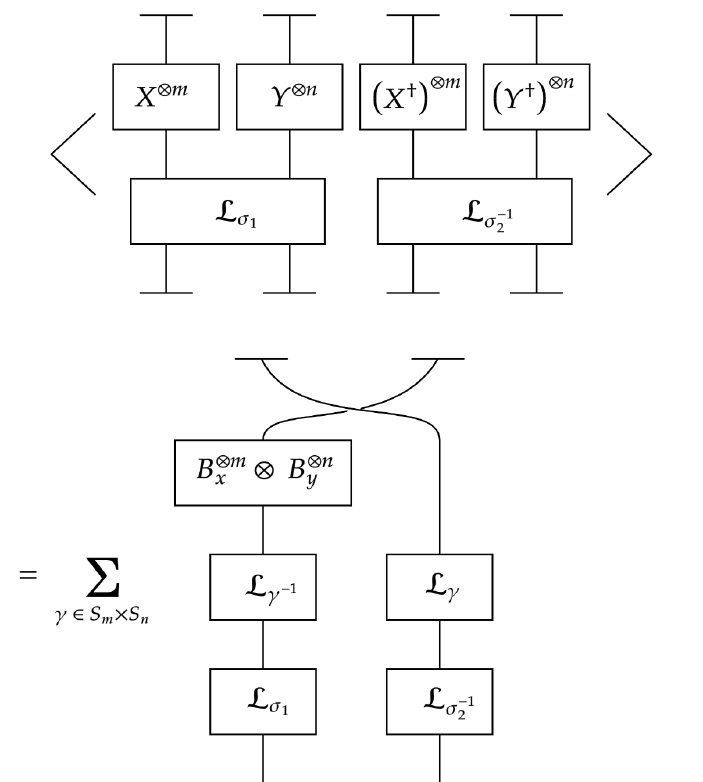
Figure 5 . The diagrammatic representation of the general two-matrix correlator with coupling matrix fields. As in the one-matrix case, this shows that the correlator can be written as a sum over permutations with a swap in the indices. Note that here γ is an element of S m × S n (the direct product of symmetric groups of m and n objects), as required by the appropriate equivalence